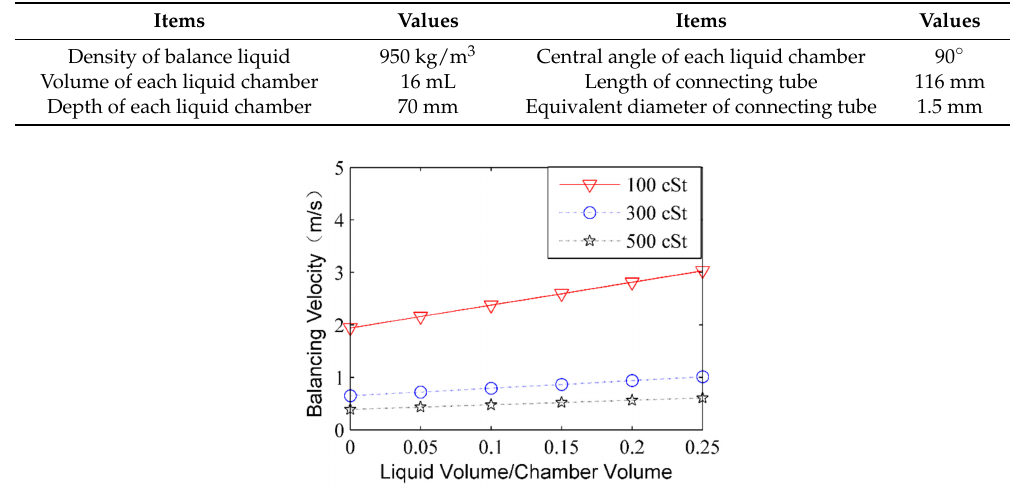
Figure 5. Balancing velocity of the balance